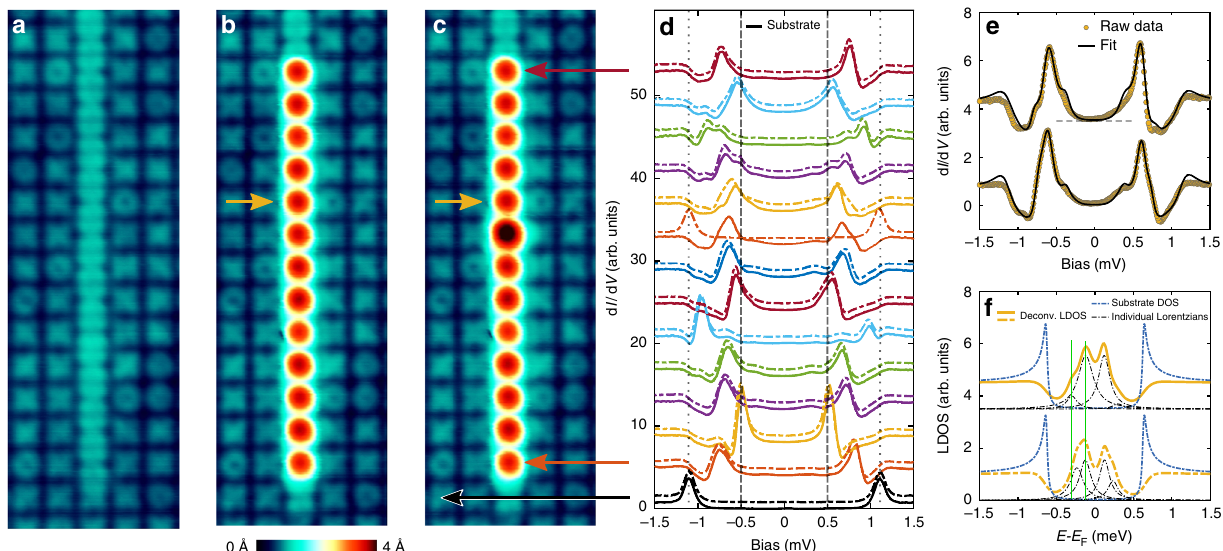
Fig. 5 Spectroscopy on a chain of 13 atoms. a STM image of manipulated IFAs before the construction of the chain. b , c STM images of the chain with the sixth atom from the top in YSR-on and YSR-off state, respectively. The remaining atoms are in the YSR-on state for the two cases. d d I /d V spectra taken with a superconducting tip on each adatom of the chain corresponding to b (continuous curves) and c (dashed curves). Black curves at the bottom represent substrate spectra. The spectra are shifted vertically for clarity. The dashed (dotted) vertical lines indicate the sample Fermi level (sample coherence peak). e d I /d V spectra on the fi fth atom from the top (same as orange curves in d , together with the fi ts from numerical deconvolution of the spectra in two different situations corresponding to b (top curves) and c (bottom curves). f The numerically deconvoluted LDOS corresponding to the fi ts in e . The substrate DOS is plotted as a reference. Vertical green lines in f are guides to the eye showing the peak position of the YSR states in the upper most curve. Stabilization parameters for STS: V stab = 2.5 mV, I stab = 100 pA, V mod = 20 μ V and scan parameters: V = 50 mV, I = 50